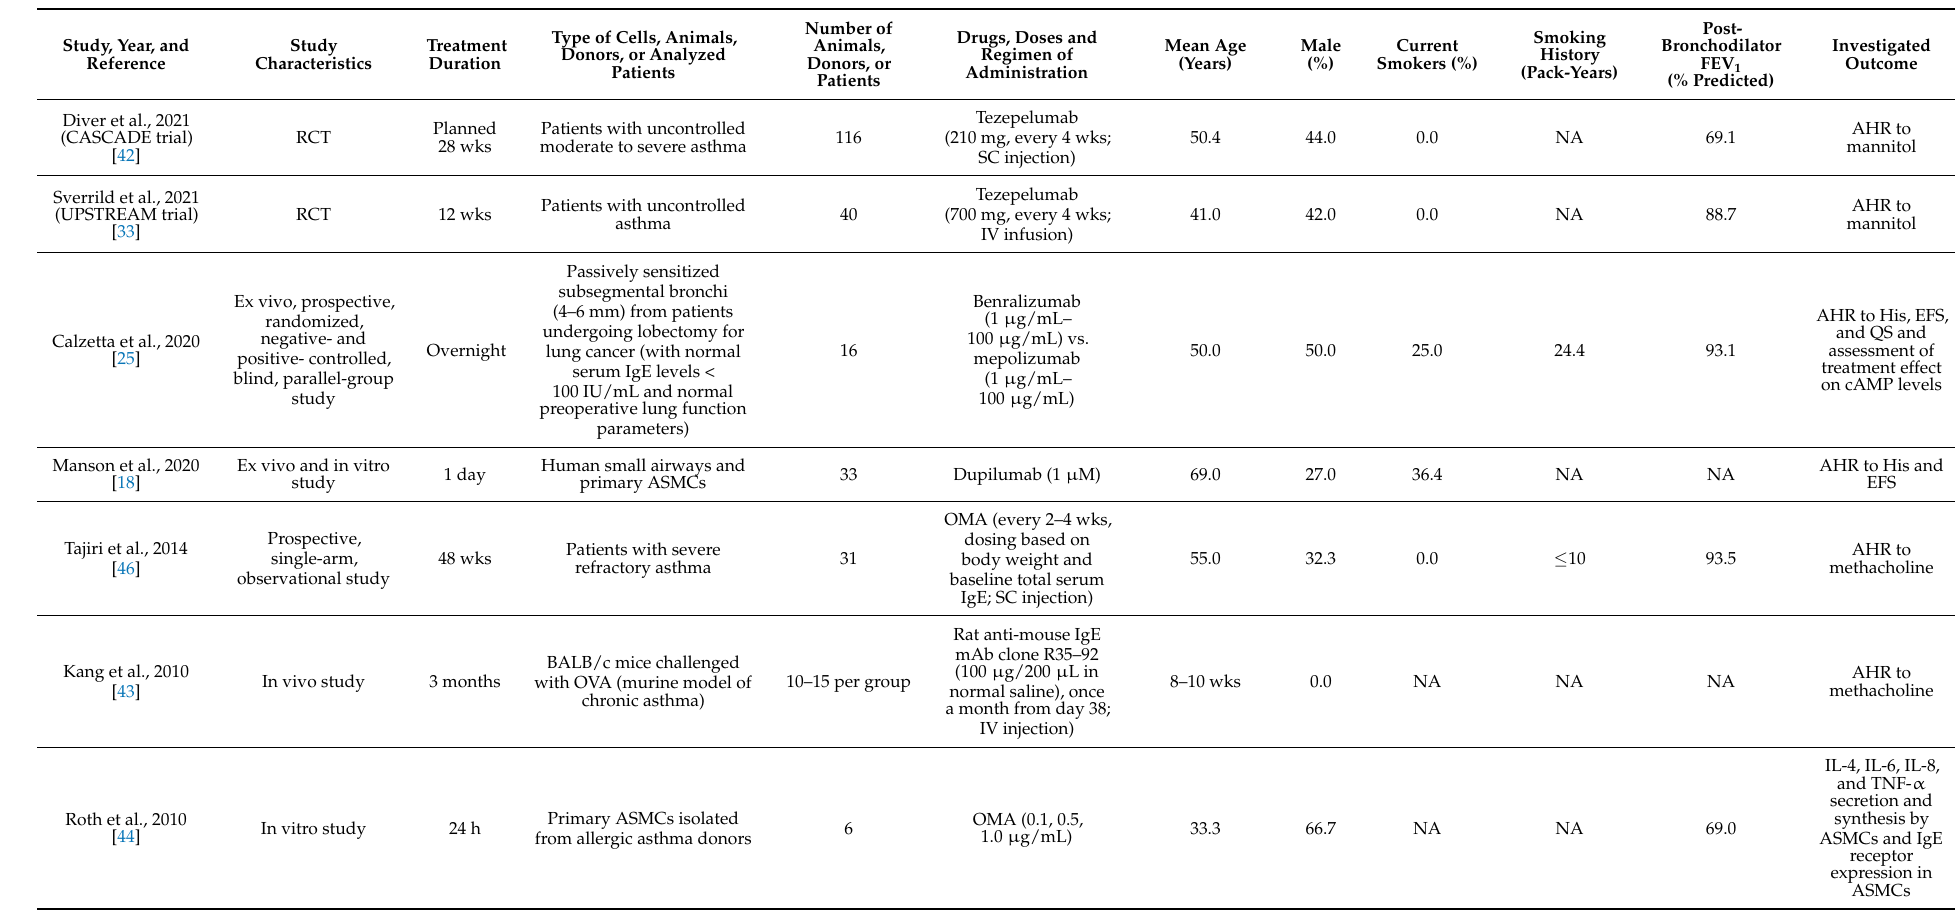
Table 1. Main characteristics of the studies included in the systematic